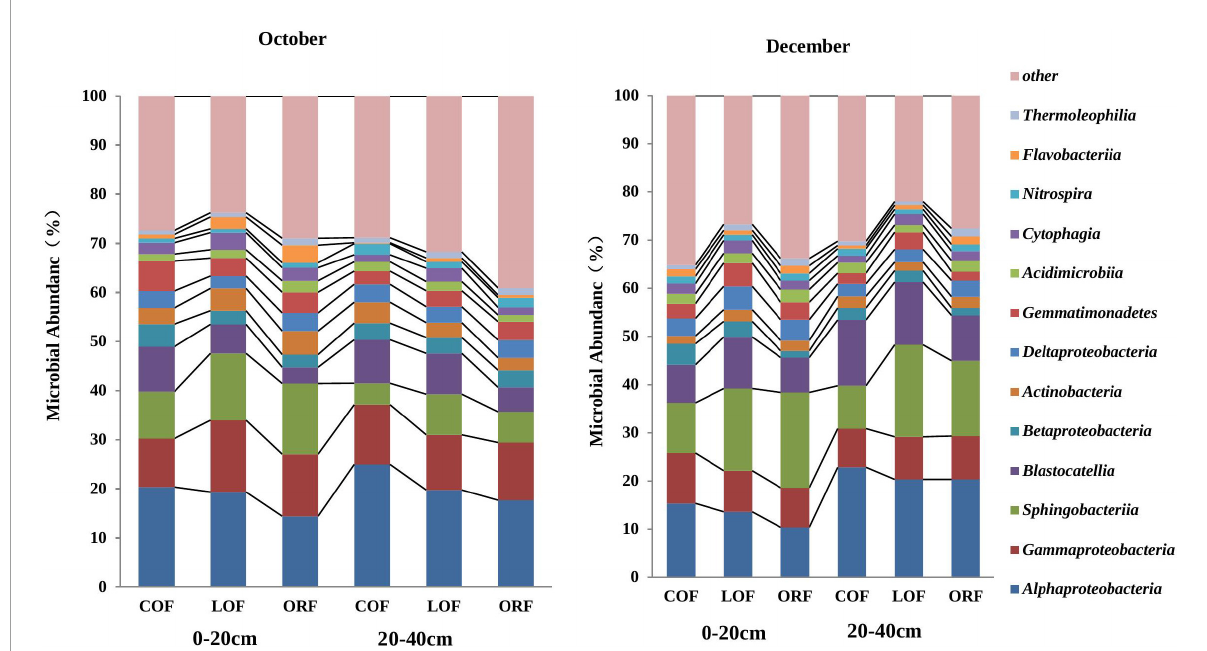
FIGURE4 Effect of different farming practices on soil microbial abundance at phylum levels within different soil depths and sampling months. Where, October and December- Months of soil sampling; COF, Conventional farming; LOF, Low input farming; ORF, Organic farming; 0–20 and 20–40 (cm)—Soil depth from where soil samples were collected.